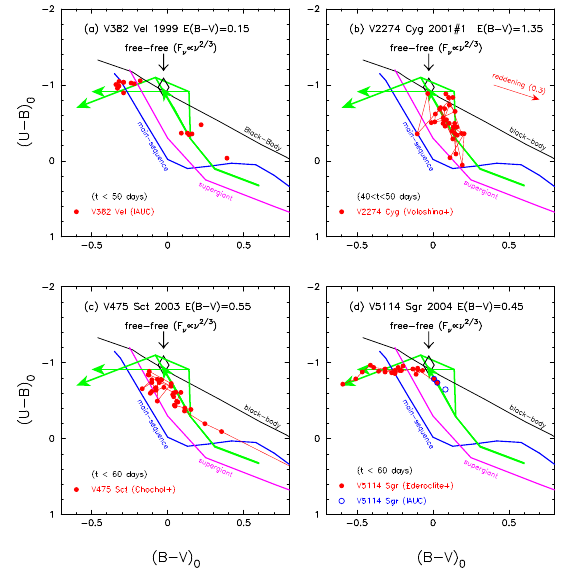
Figure 8: (a) V382 Vel, (b) V2274 Cyg, (c) V475 Sct, and (d) V5114